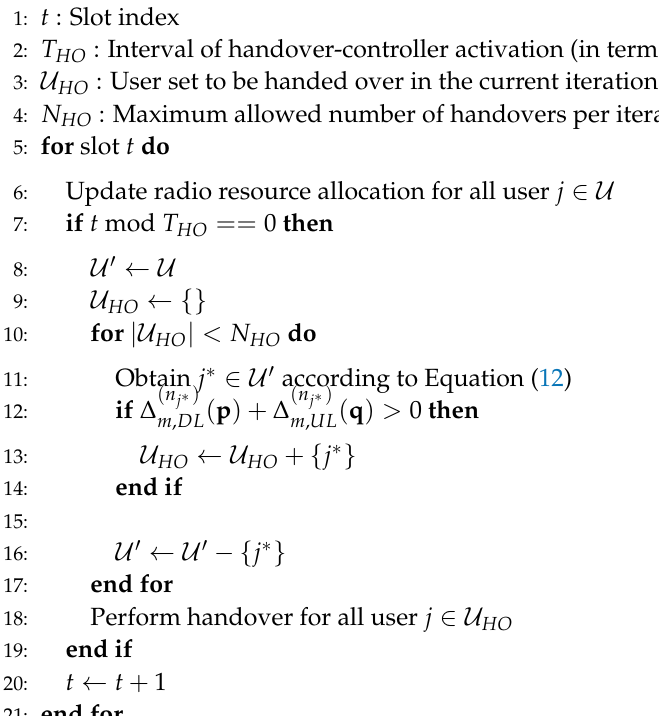
Algorithm 1 Handover control